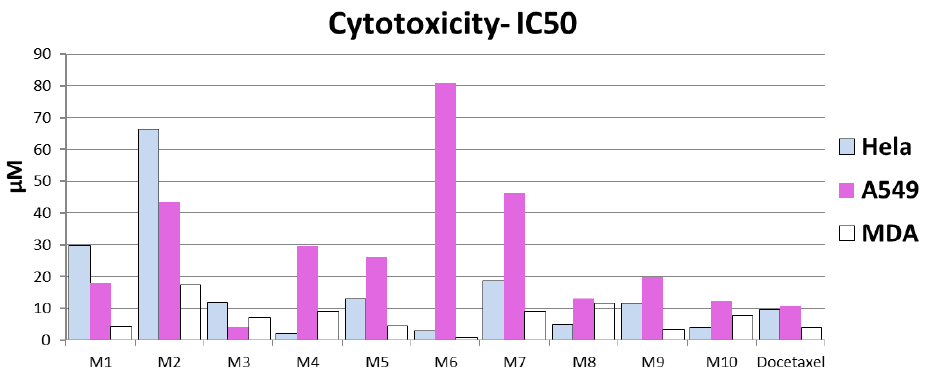
Figure 3. Representative graph showing the most active compounds in every cell line, where Hela cell line columns are in blue, A549 cell line columns are in purple, and MDA cell line columns are in white.